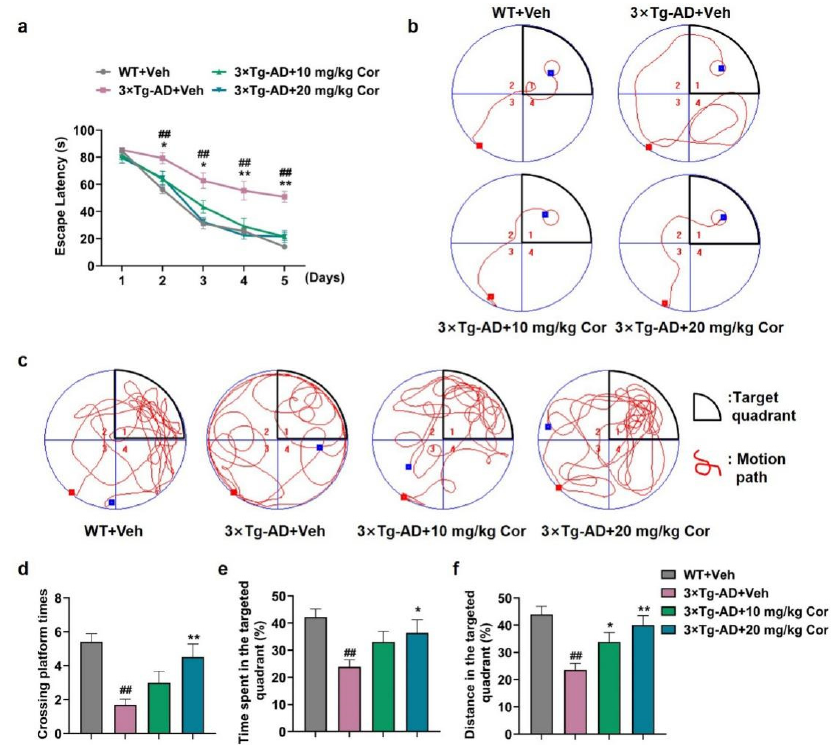
Figure 1. Cornuside alleviated the learning and memory deficits among 3 × Tg-AD mice. Training trials were implemented 4 times daily for a total of 5 successive days. The distance and duration of swimming prior to the platform arrival were documented in an automatic manner. Twenty-four hours after the trials, probe tests were conducted. ( a ) The escape latency. ( b ) The representative track in the probe test on the 5th day for the mice. ( c ) The representative track in the platform-free probe test on the 6th day for the mice. ( d ) The number of platform crossings in the probe test. ( e ) Time consumption within the target quadrant. ( f ) Overall distance of swimming within the targeted quadrant. Data are all denoted as mean ± SEM ( n = 10 in each group). ## p < 0.01 vs. WT + Veh group; * p < 0.05 and ** p < 0.01 vs. 3 × Tg-AD + Veh group.